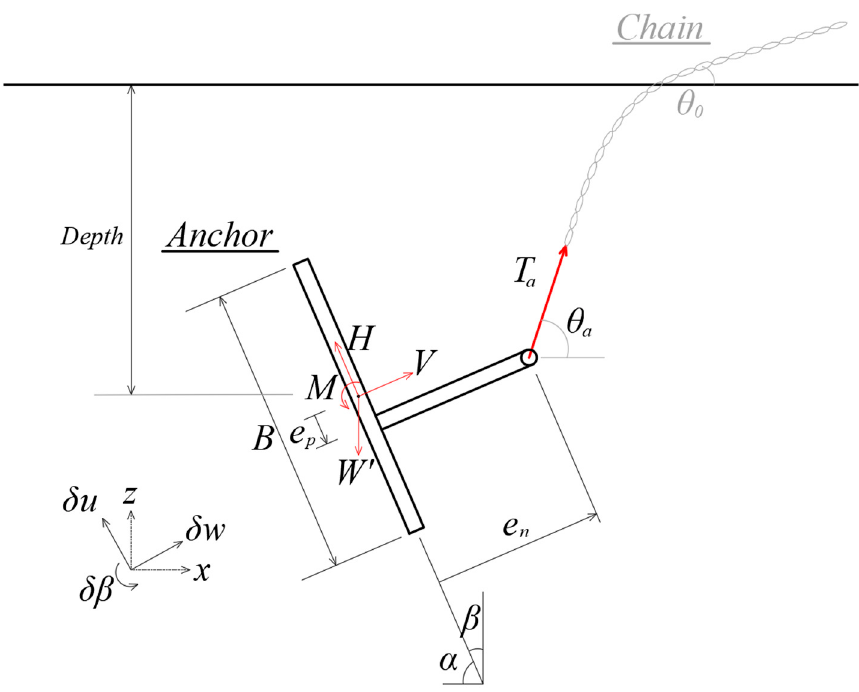
Figure 1. Schematic two ‐ dimensional representation of the anchor and chain geometry and definition of force, displacement and geometrical variables.